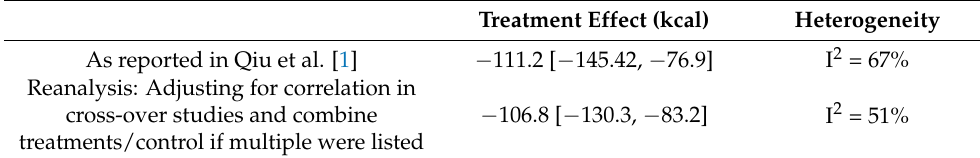
Table 1. Associations between protein-rich breakfast and subsequent energy intake (kcal) from a meta-analysis with random effects